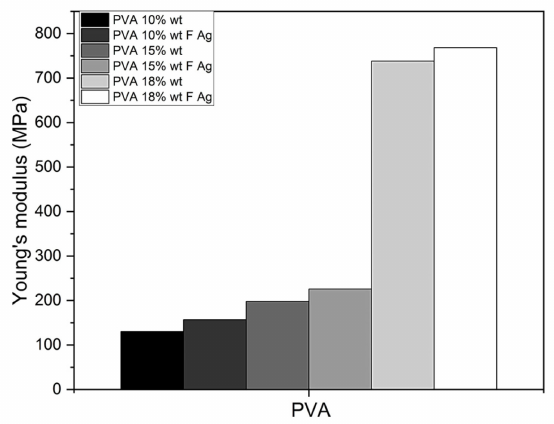
Figure 5. Young’s modulus ( E ) of PVA membranes.